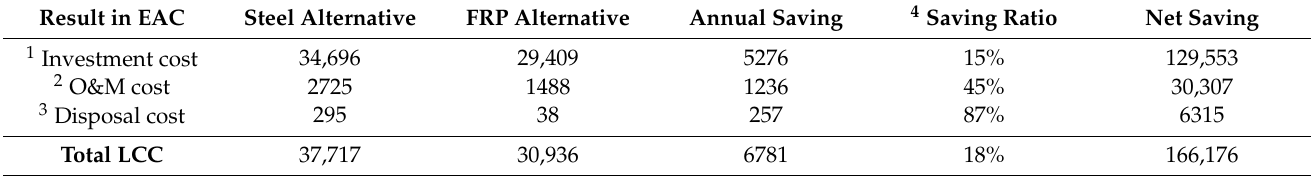
Table 6. LCC analysis results expressed as